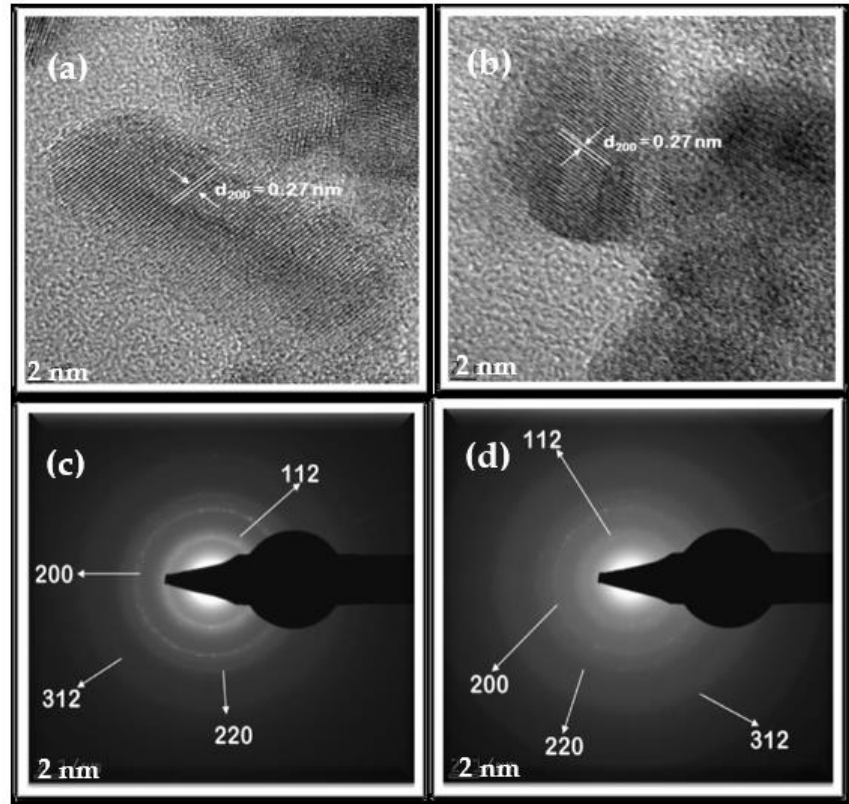
Figure 5. High-resolution transmission electron microscopy (HRTEM) micrographs showing lat- tice fringes for ( a ) CZTS and ( b ) CZTSTe. The selected area electron diffraction (SAED) images for ( c ) CZTS and ( d ) CZTSTe.